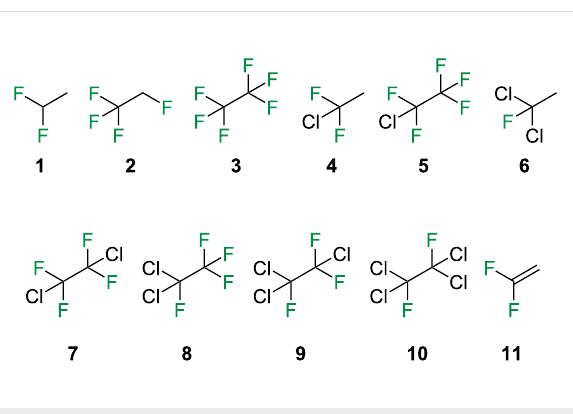
Figure 6: Chemical structure of the compounds 1 – 11 analyzed herein.